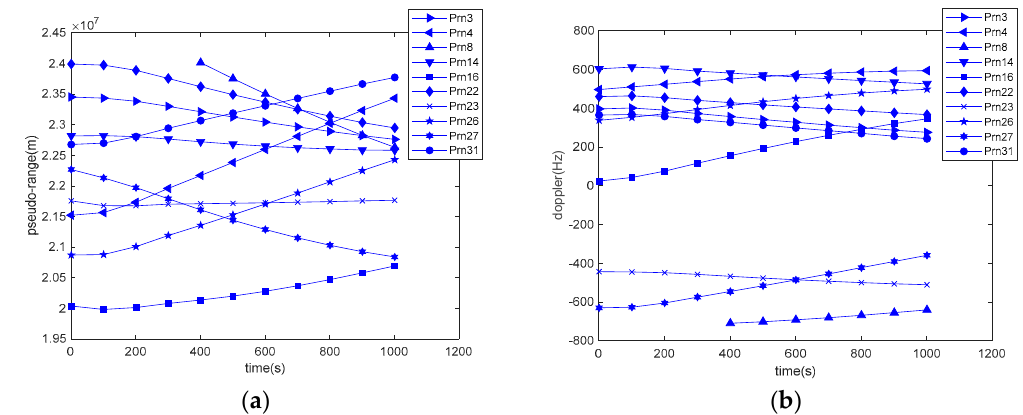
Figure 12. Positional dilution of precision of satellites.